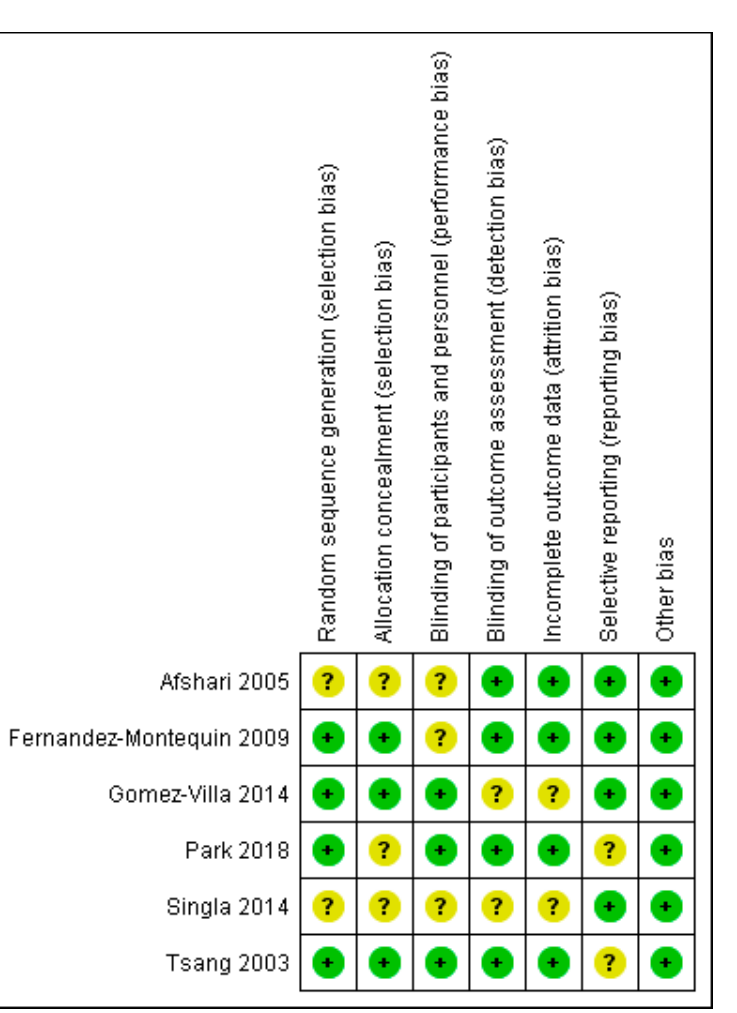
Figure 4. Risk of bias summary assessed for each eligible study.